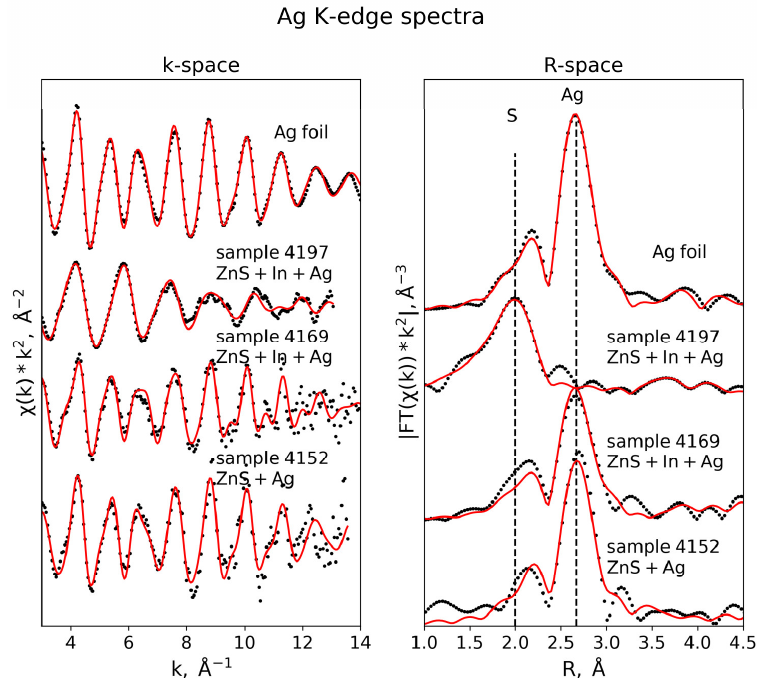
Figure 8. Ag K -edge EXAFS spectra of doped sphalerite samples and metallic Ag as a reference (see